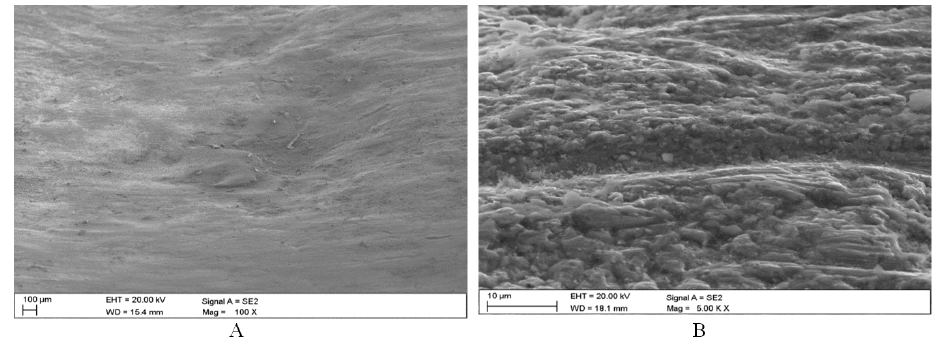
Figure 11. Surface damage of the sprocket made of the L20HGSNM cast steel, ( A )—micro-cutting marks, ( B )—surface fractures, SEM.